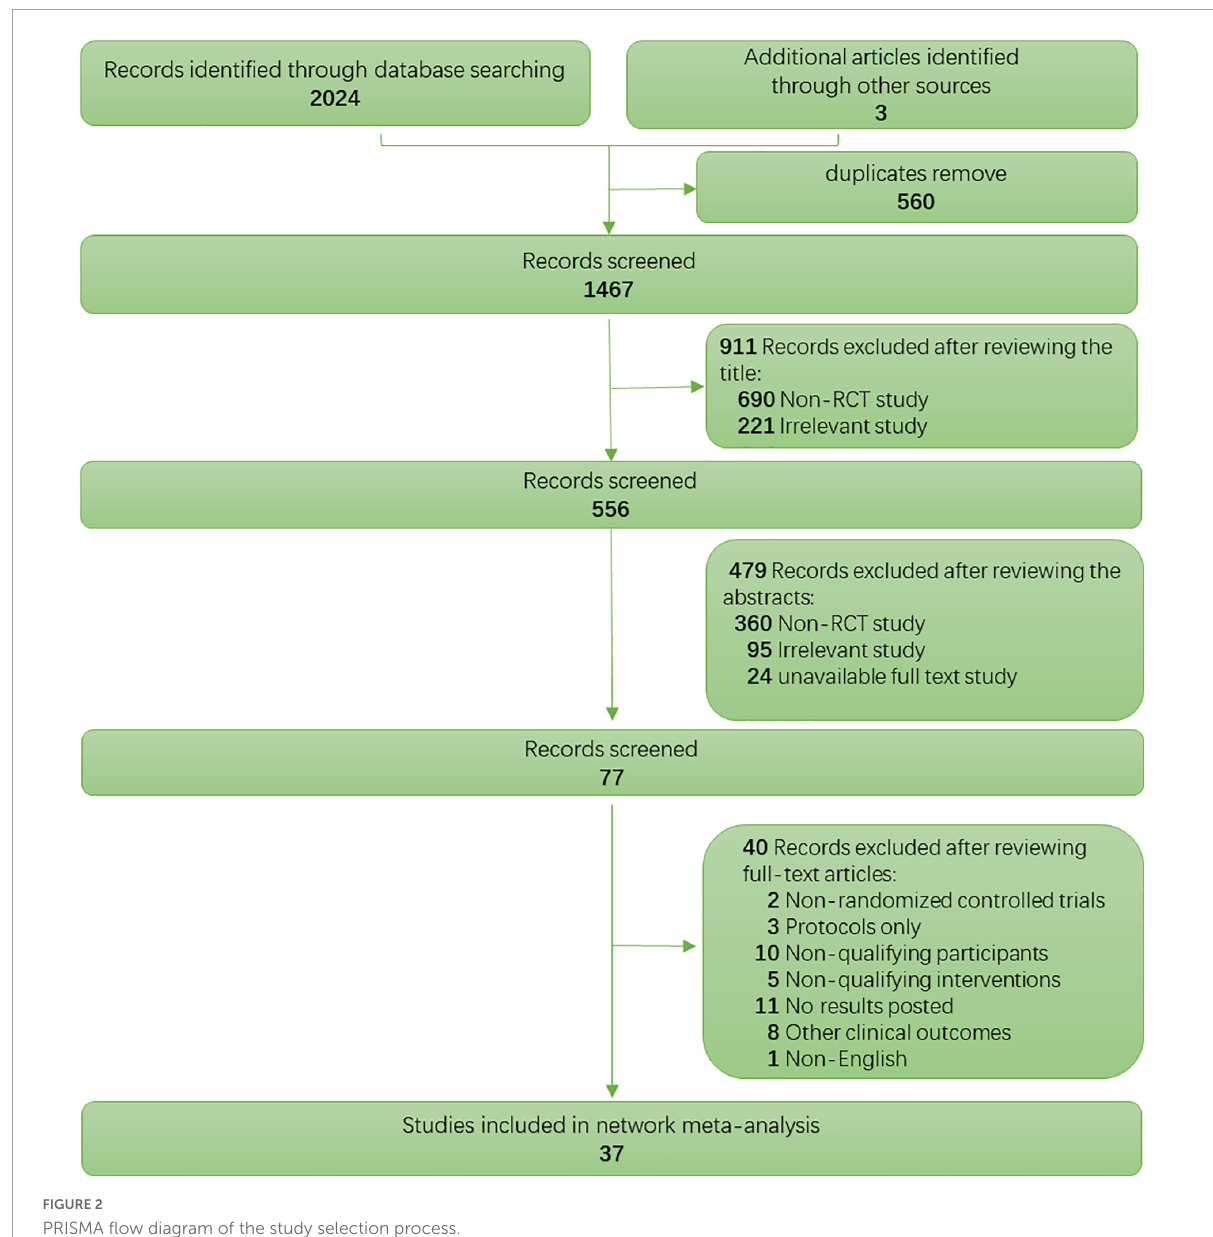
( Table 1 ). The SUCRA results showed that LFL-LFR-sup-rTMS (70.6%), LFR-sup-rTMS (70.0%), and HFL-sup-rTMS (64.9%) were ranked in the three first positions for the